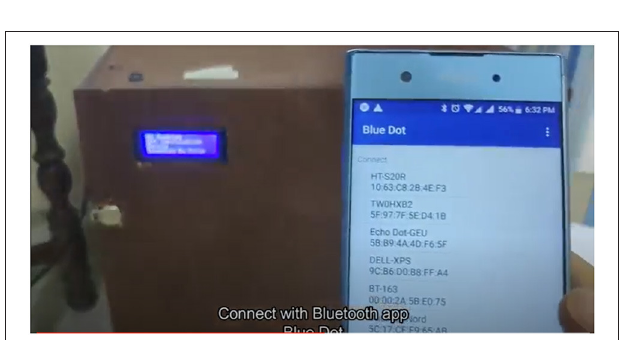
FIGURE 15 | Device internal view - processing unit and cooling fans.